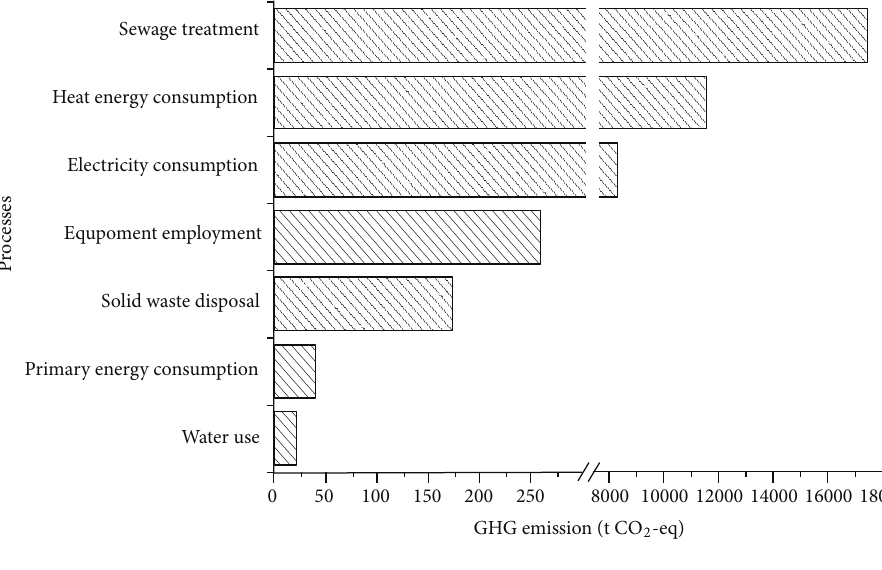
F 2: GHG emission of operation